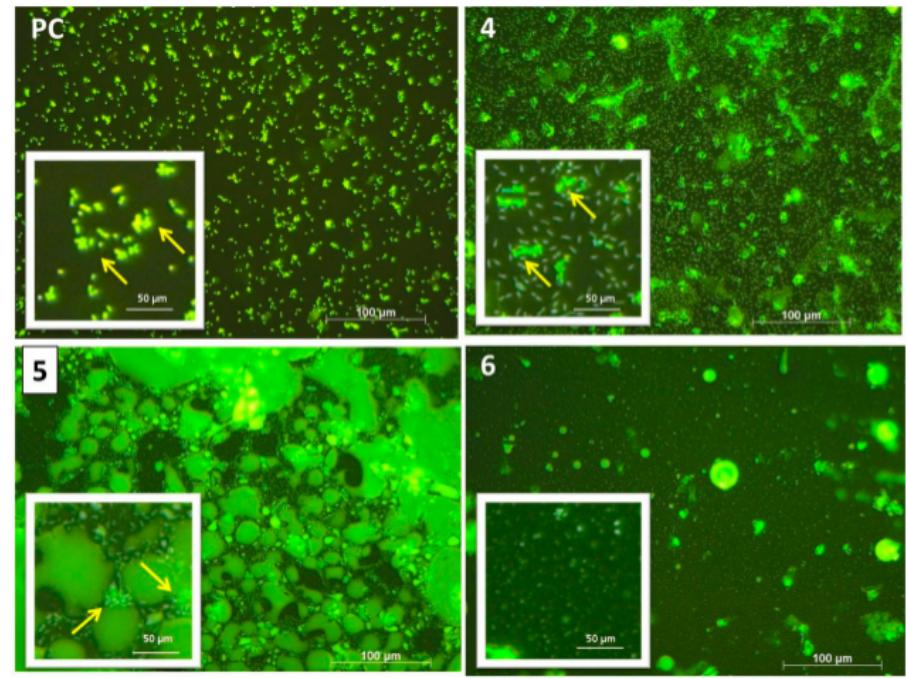
Figure 3. Fluorescent microscopy pictures of SYTO 9 stained C. marina biofilms formed after a 1 h incubation on (PC) positive control, glass slide with staining procedure and bacteria and on glass samples with PEG-silane co-cross-linked coatings containing modifying agent: (4) 4.0 wt % ES40 + 2.0 wt % PEG-silane + 0.5 wt % NIS; (bacteria and staining); (5) 4.0 wt % ES40 + 2.0 wt % PEG-silane + 2.0 wt % AO; (bacteria and staining); (6) 4.0 wt % ES40 + 2.0 wt % PEG-silane + 0.5 wt % NIS + 1.5 wt